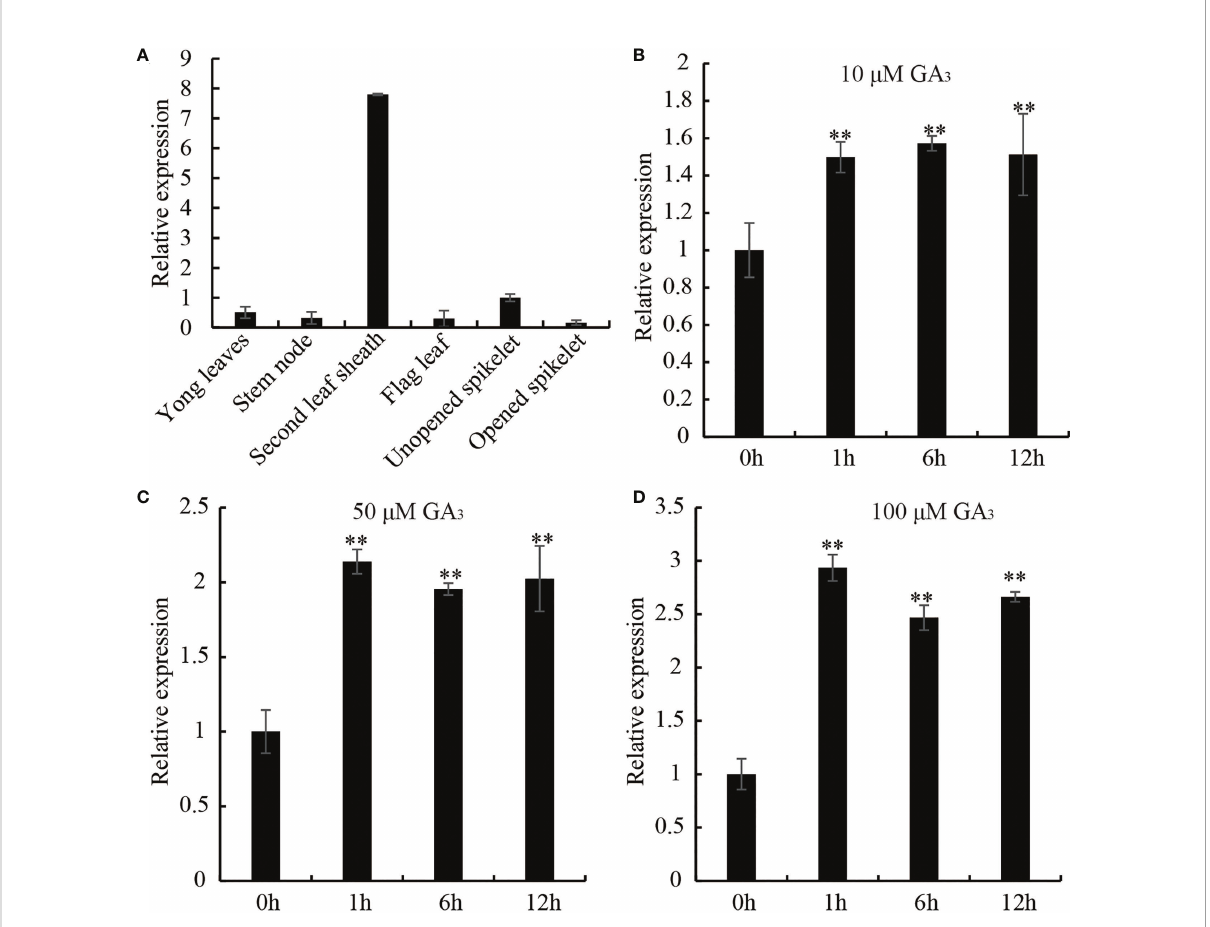
FIGURE 1 Expression pattern of OsDREB2B in rice. (A) Transcript levels of OsDREB2B in various tissues and organs tested by qRT-PCR. Transcript level of unopened spikelet was set to 1. Data are the mean ± SD (n = 3). (B – D) Expression pro fi les of OsDREB2B in response to different concentrations of GA 3 application analyzed by qRT-PCR. Student ’ s t-test was used to generate the P values. **Signi fi cant differences between the WT and OE plants at P =